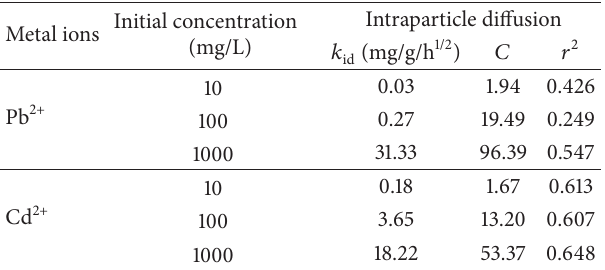
Table 5: Intraparticle diffusion parameters for adsorption of Pb 2+ and Cd 2+ on 30/70 HAp/chitosan hybrid